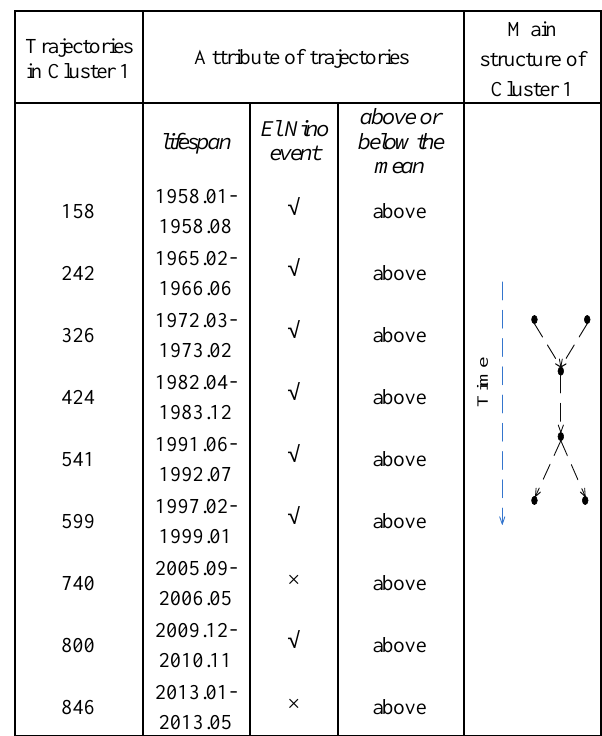
Table 1. Related information of Cluster